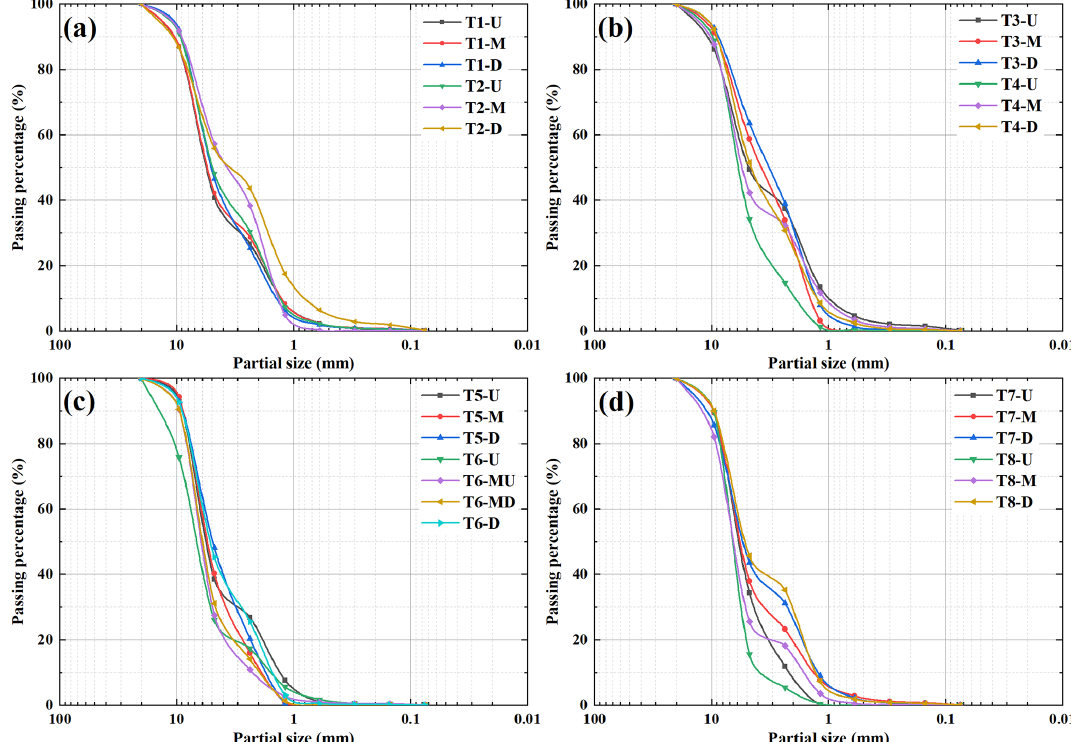
Figure 4. Gradation curve of the boulder bar materials: (a) for T1 and T2 tests; (b) for T3 and T4 tests; (c) for T5 and T6 tests; (d) for T7 and T8 tests. Notation: U, M, D, MU, and MD represent the boulder bar near the upstream reaches, the boulder bar near the middle reaches, the boulder bar near the downstream reaches, the boulder bar near the middle-upstream reaches, and the boulder bar near the middle-downstream reaches,